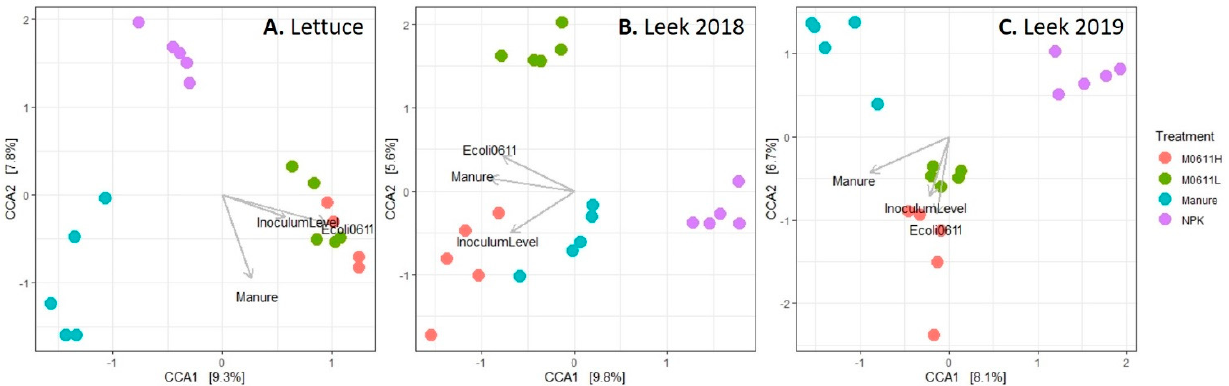
Figure 2. Canonical correspondence analysis ordination biplots on bacterial community composition of lettuce ( A ), leek 2018 ( B ) and leek 2019 ( C ) rhizosphere soil samples under four treatment regimens. Direction of vectors for treatments of ‘Manure’ (untreated manure, M0611H, M0611L) and NPK, ‘Inoculum Level’ (M0611H versus M0611L) and ‘ E. coli 0611’ (presence of strain 0611 in M0611H and M0611L versus absence in untreated manure and NPK treatments) are indicated by arrows in the biplot. The impact of ‘Manure’ on bacterial community composition in lettuce, leek 2018 and leek 2019 rhizosphere soils was significant at levels of, respectively, 0.012, 0.011 and 0.013 (PERMANOVA, R 2 values, respectively, 0.24, 0.18, 0.24) and of ‘ E. coli 0611’ was, respectively, 0.008, 0.033, 0.025 (PERMANOVA, R 2 values, respectively, 0.24, 0.17, 0.15).